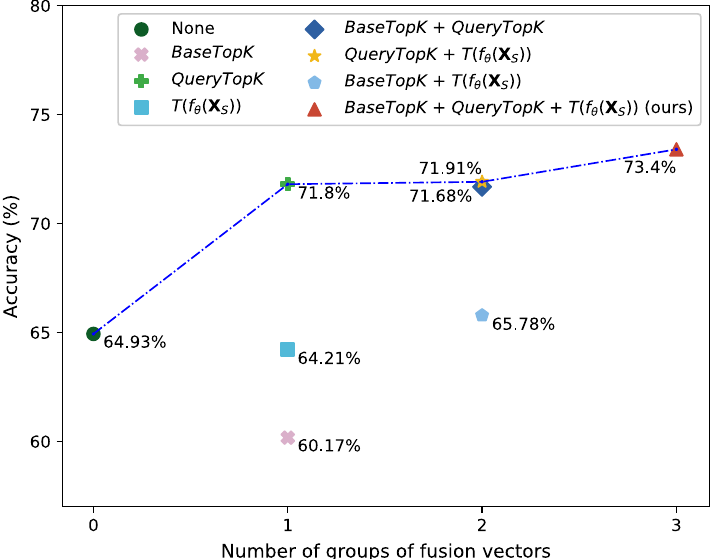
Figure 3. Experimental results of different fusion information on 5-way 1-shot task of miniImageNet dataset. The X-axis coordinate represents the number of groups of fusion vectors, and the Y-axis represents the accuracy of the LR model. Each shape point represents a fusion combination. The number near the shape points represents the accuracy of the LR model. Blue dashed polylines connect the models with the highest accuracy for each number of groups of fusion